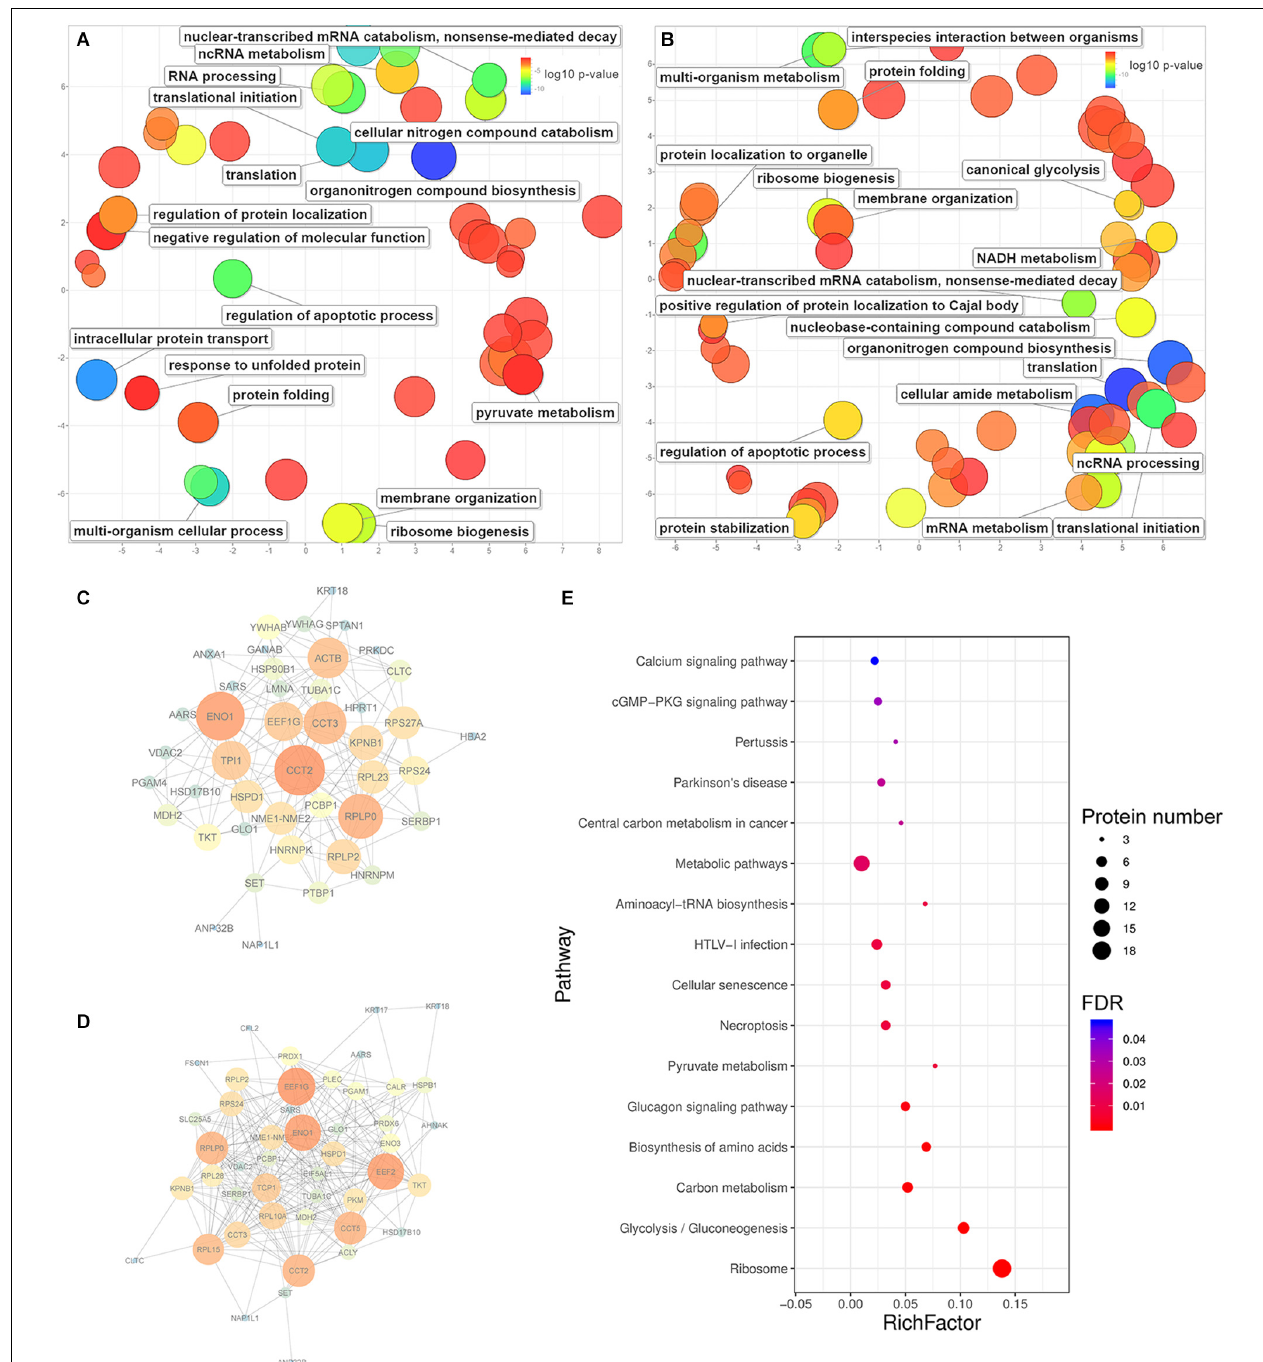
FIGURE 5 | The enrichment of biological processes, protein-protein interactions and KEGG pathways predicted from significantly upregulated proteins identified in HeLa cells with the treatments of caerin 1.1 or 1.9. The enriched biological processes (Bonferroni-corrected P -values < 0.05) in HeLa cells with caerin 1.1 (A) and 1.9 (B) treatments; the PPI network predicted based on significantly regulated proteins induced by caerin 1.1 (C) and 1.9 (D) treatments; the KEGG pathways enriched by caerin 1.9 treatment (E) (see Supplementary Table 5 for all enriched processes, functions and cellular components).